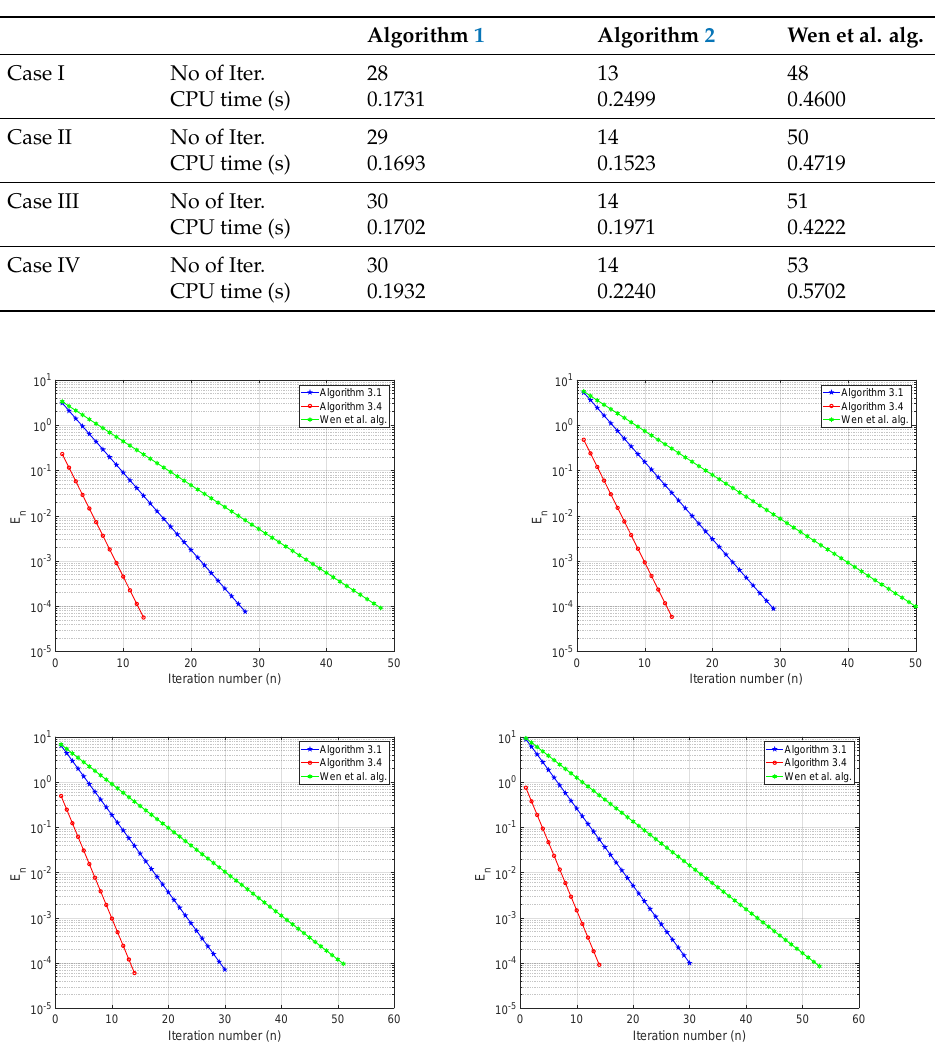
Algorithm 3.1 Algorithm 3.4 Wen et al. alg.